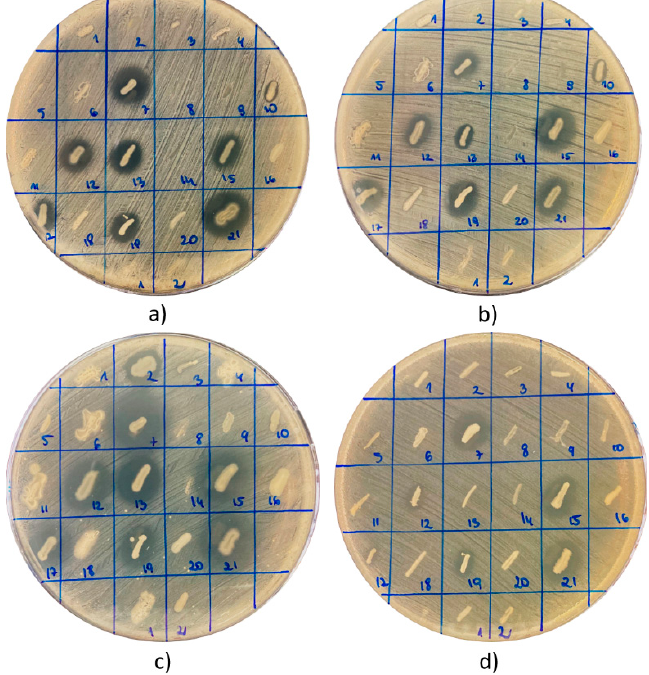
Figure 1. An example of antagonistic interaction between isolated strains (strains 1–21 were isolated from the product BB19, and strains 1 and 2 were derived from the product BB3) and indicatory/reference strains of pathogenic bacteria: ( a ) S. aureus ATCC 25923, ( b ) S. aureus ATCC 29213, ( c ) S. epidermidis ATCC 12228, and ( d ) E. coli ATCC 25922. Interactions with P. aeruginosa ATCC 27853 were a separately analyzed (results not presented).